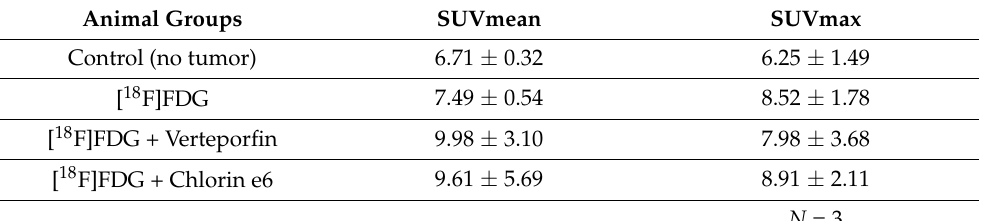
Table 1. Biological uptake in ES2 xenograft models at 5 h after [ 18 F]FDG